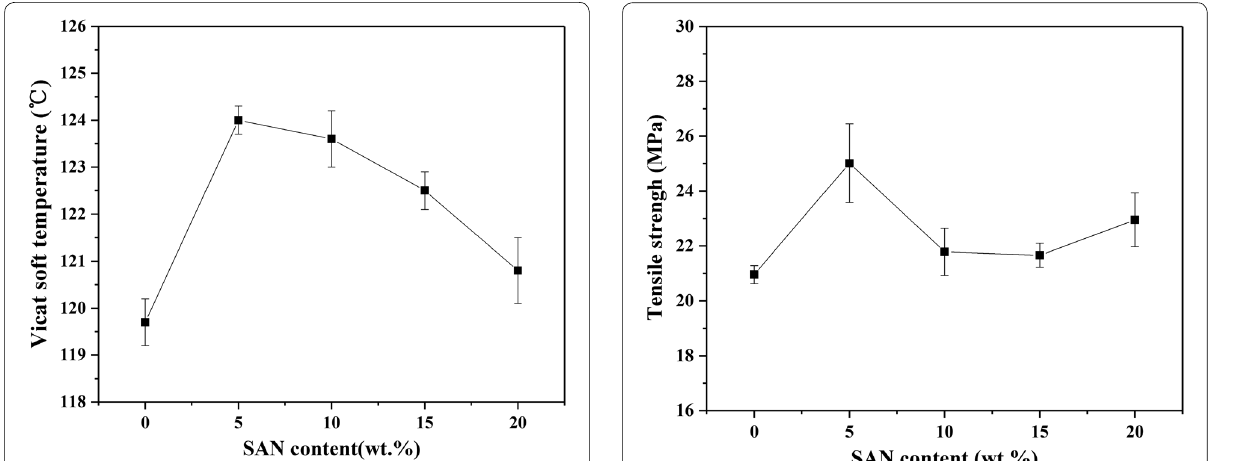
Fig. 9 Tensile strength of PP and SAN/PP